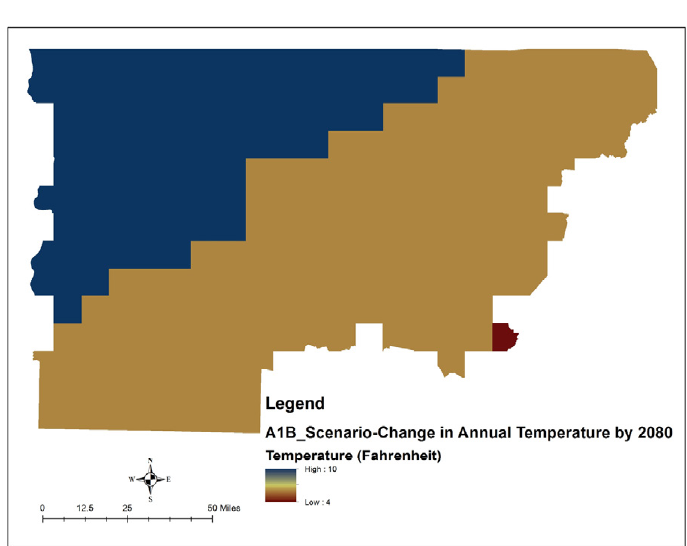
Fig. 3c: Input variable (Projected Temperature) used in modeling inland wetlands’ vulnerability to human and natural stressors by the year 2080